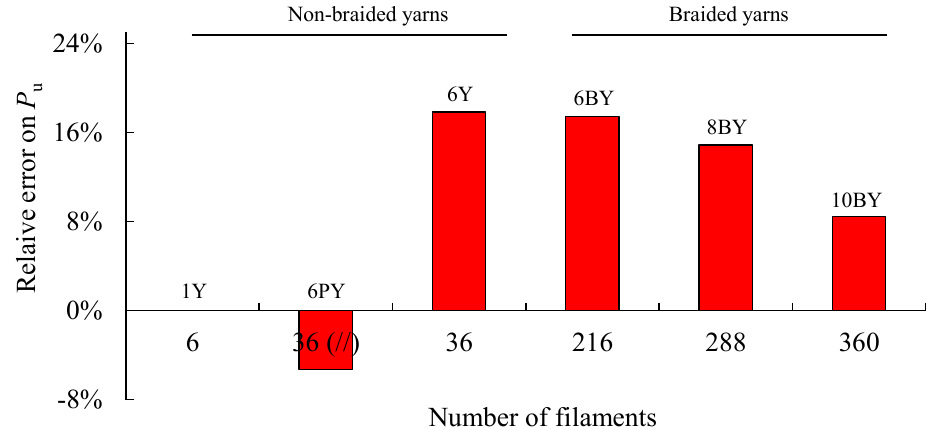
Figure 9. Comparison of mean values (from 28 results) of ultimate load ( P u ) as a function of the number of PVA filaments used in the analysed structures.